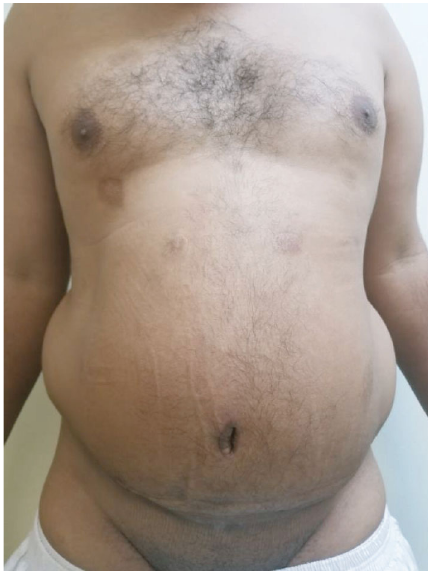
Figure 5: 2 months postoperative